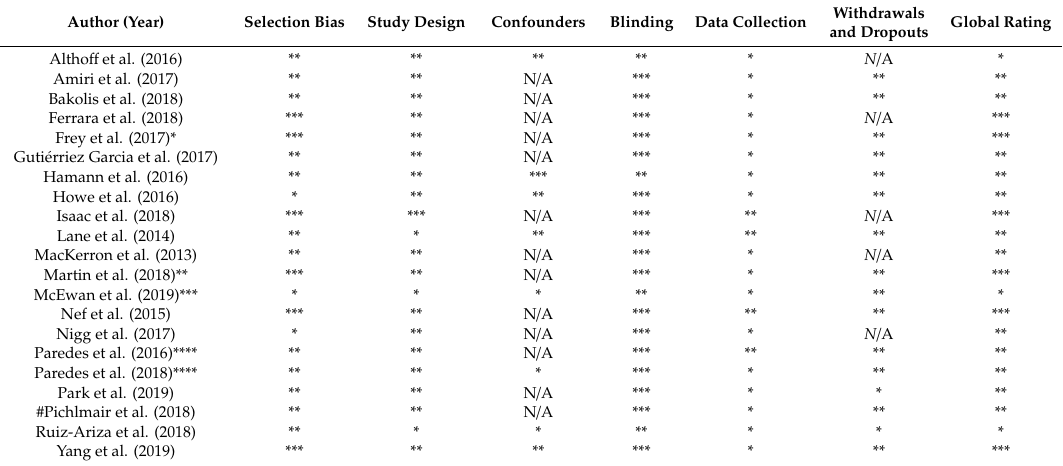
Table 1. Quality Assessment of quantitative articles included in the systematic review ( n =